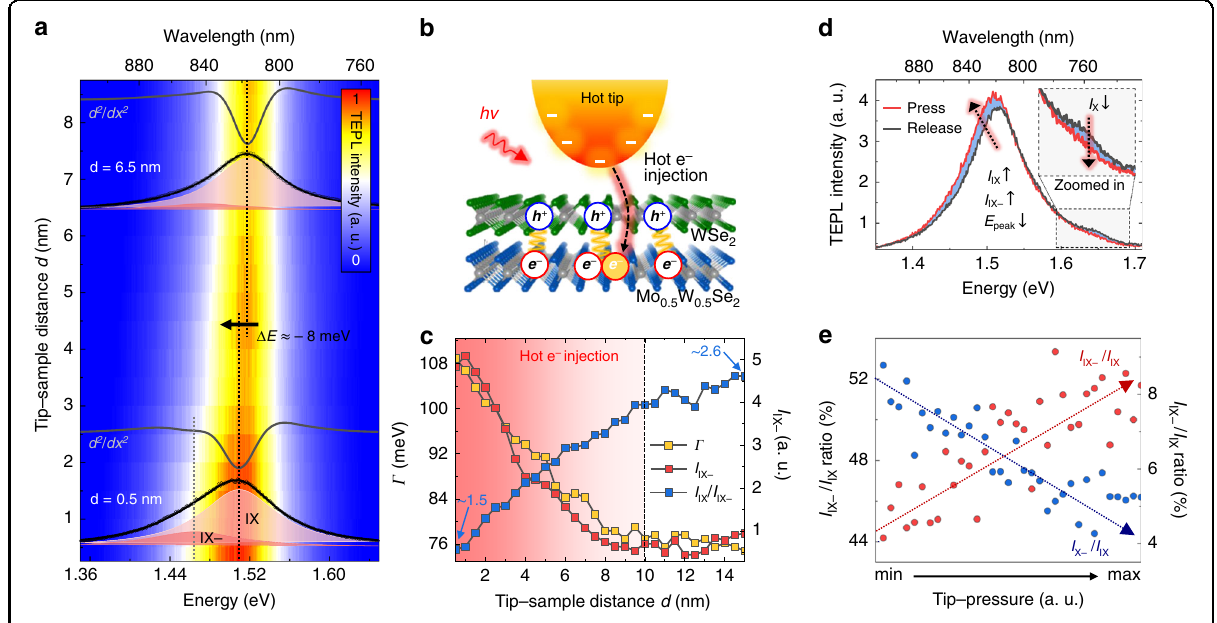
Fig. 4 Inducing and controlling of IX − via hot electron injection of the Au tip. a TEPL spectra of the heterobilayer with respect to the tip-sample distance d at the high excitation intensity ( ≈ 10 9 W/m 2 ) exhibiting apparent emergence of the IX − shoulder. For the selected TEPL spectra at d = 6.5 nm and d = 0.5 nm, interlayer exciton (IX, black dashed line) and interlayer trion (IX − , light gray dashed line) peaks are assigned by the corresponding dips in the second derivative of the TEPL spectra ( d 2 / d x 2 , gray curves) fi tted with a Lorentzian function. b Illustration for the tip- induced hot electron injection process, which stimulates the IX − generation in the heterobilayer. c Changes of the linewidth ( Γ , yellow), IX intensity ( I IX − , red), and intensity ratio of IX/IX − ( I IX / I IX − , blue) as a function of d . Γ , I IX − , and I IX / I IX − are directly derived from the TEPL spectra. d TEPL spectra when the Au tip presses (red) and releases (black) the heterobilayer exhibiting further enhancement of IX − emission via GPa scale tip-pressure. e Changes of TEPL intensity ratio for I IX − / I IX (red) and I X / I IX (blue) when the Au tip presses the